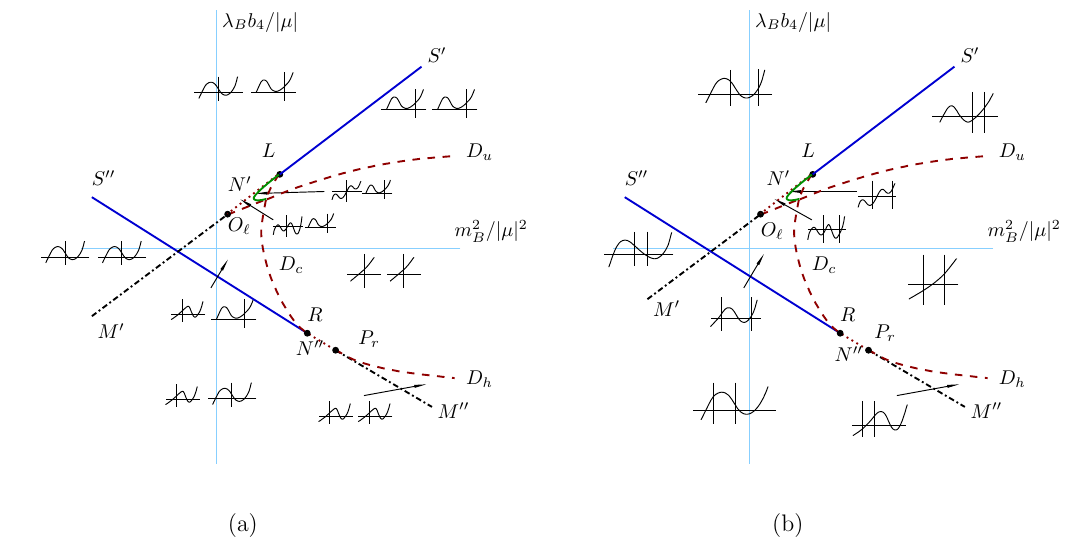
Figure 35 . Structure of the potential for φ u < x B . Recall that the effective potential is unbounded 6 from below in this case so that the ‘phases’ displayed here are dominant metastable phases when they exist. To the right of the red curve the effective potential is monotonic so no metastable phases exist. The green curve is a first order transition (between dominant metastable phases) while the blue curves are second order transitions between such phases. We have restored the | µ | dependence of the phase diagram by rescaling m 2 and λ B b 4 by appropriate powers of | µ | . B